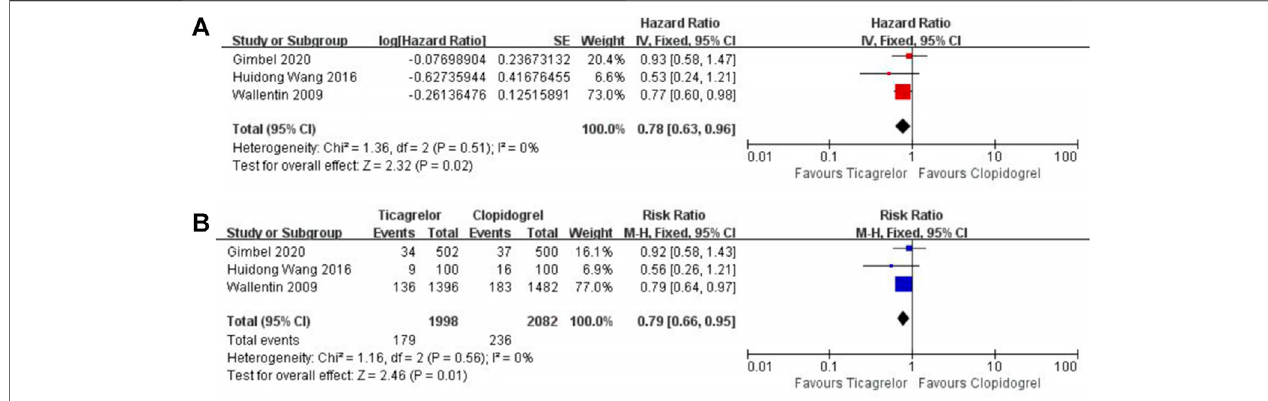
FIGURE2| Meta-analysiswithHR (A), RR (B) ,and95%CIforall-causemortality.Boxesaretherelativeriskestimatesfromeachstudy;thehorizontalbarsare95% CI. The size of the box is proportional to the weight of the study in the meta-analysis. HR, hazard ratio; RR, risk ratio; CI, con fi dence interval.